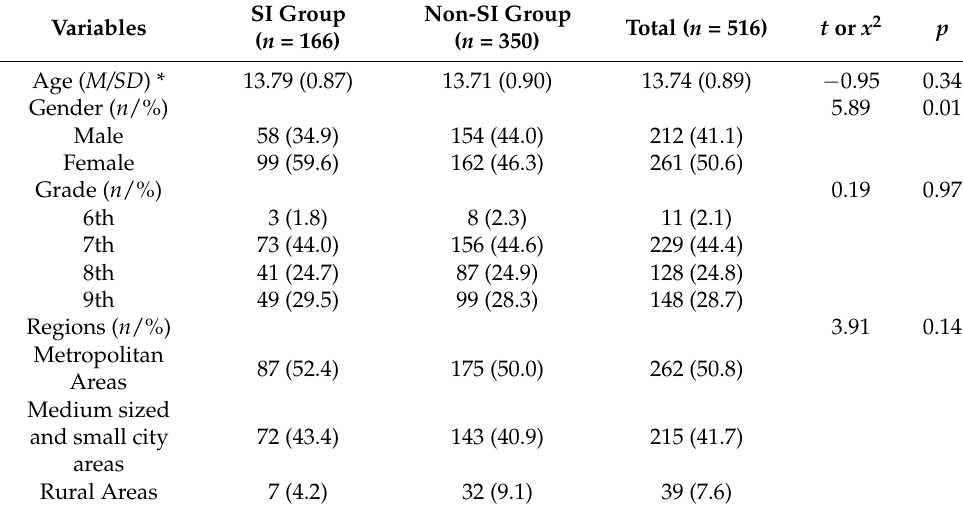
Table 1. Demographic characteristics.